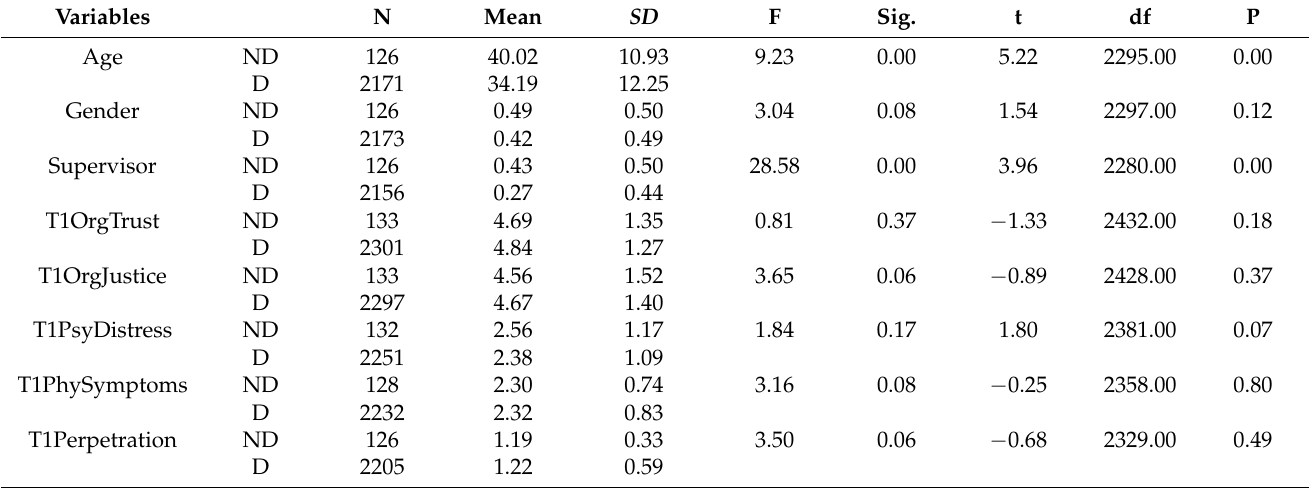
Table 1. T-test for Dropout